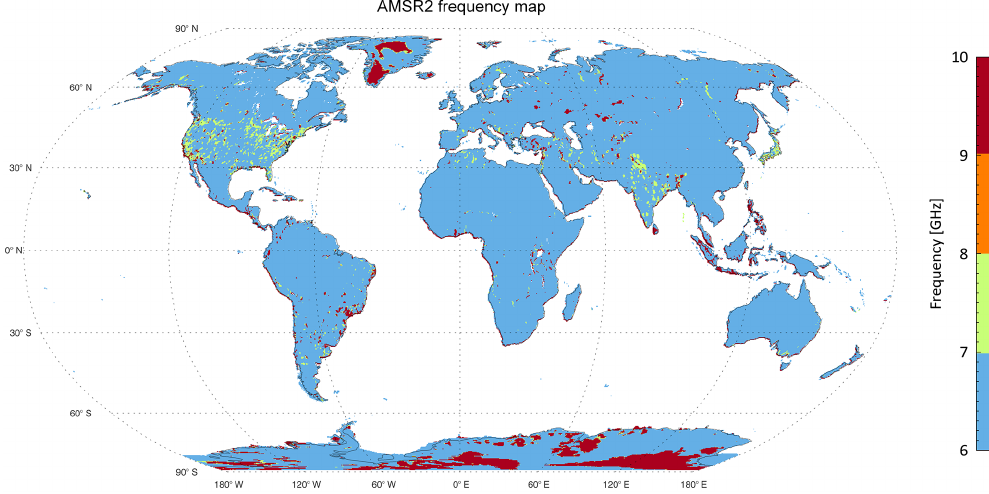
Figure A1. Global map illustrating which frequency used by AMSR2 is the least affected by RFI.